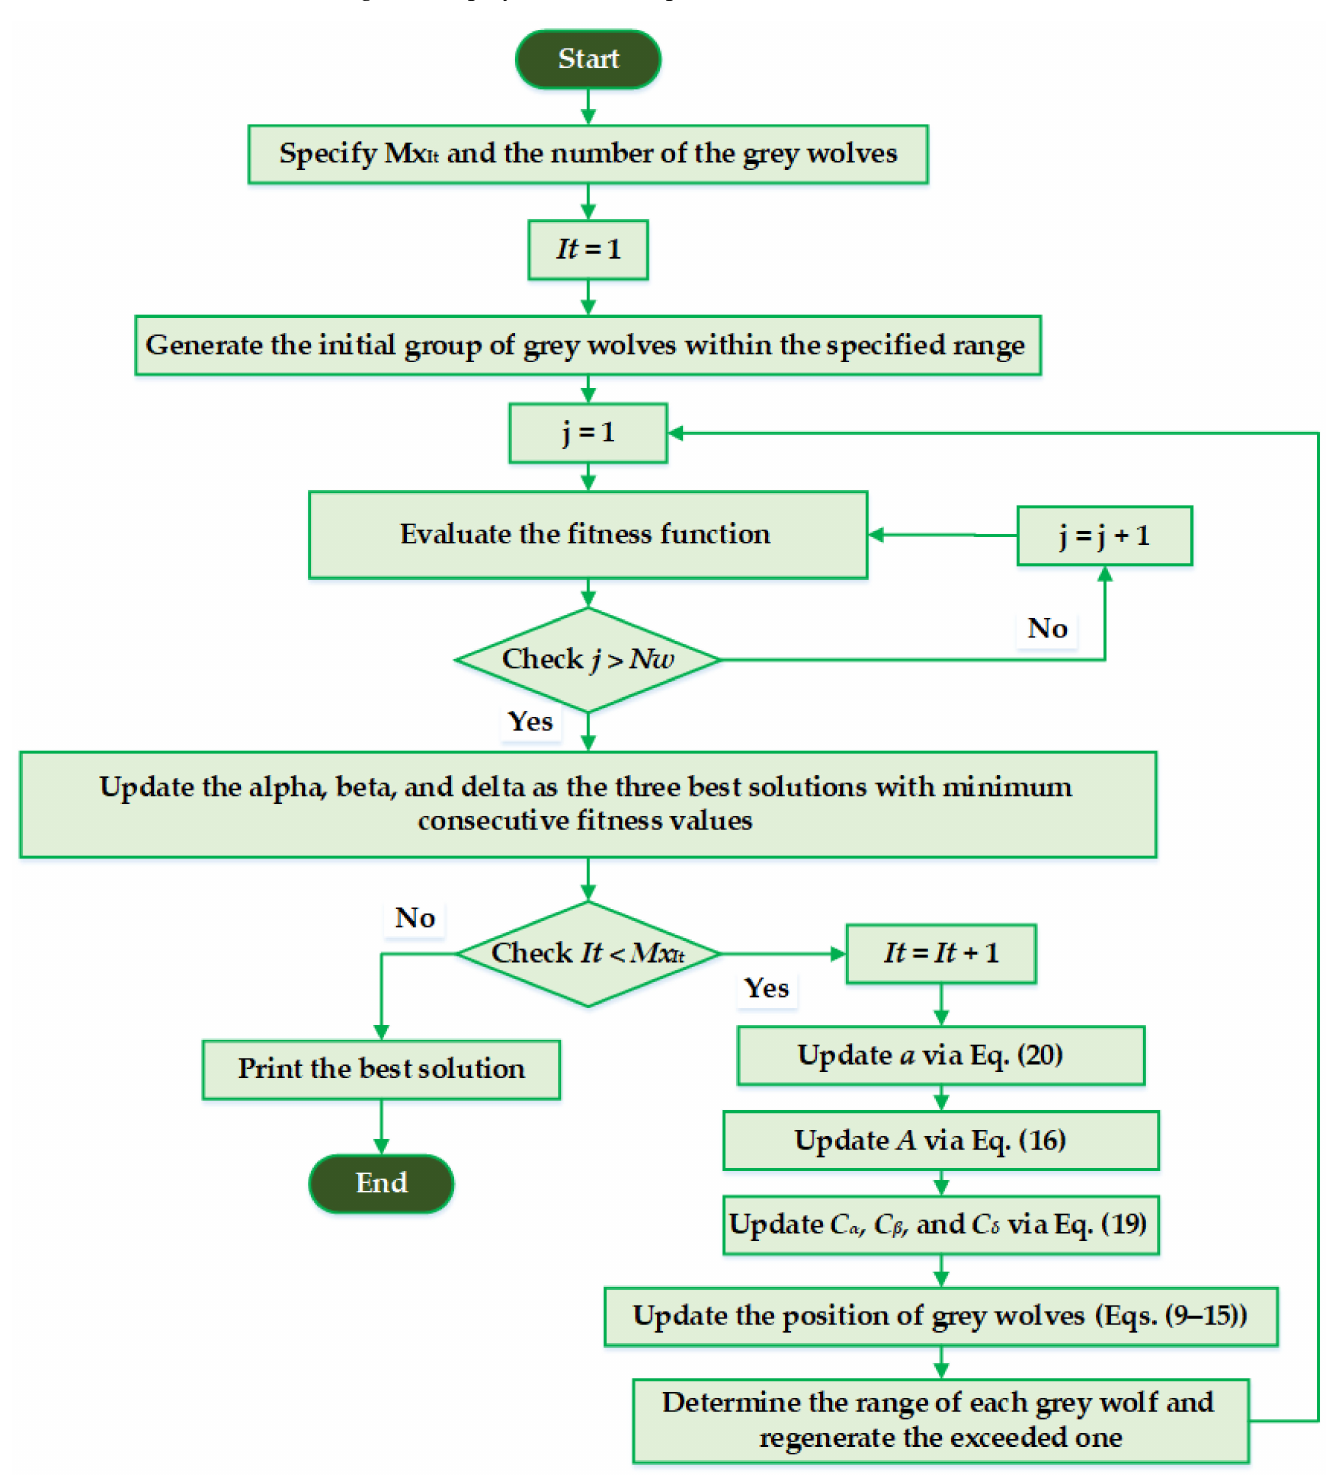
Figure 4. Basic steps of